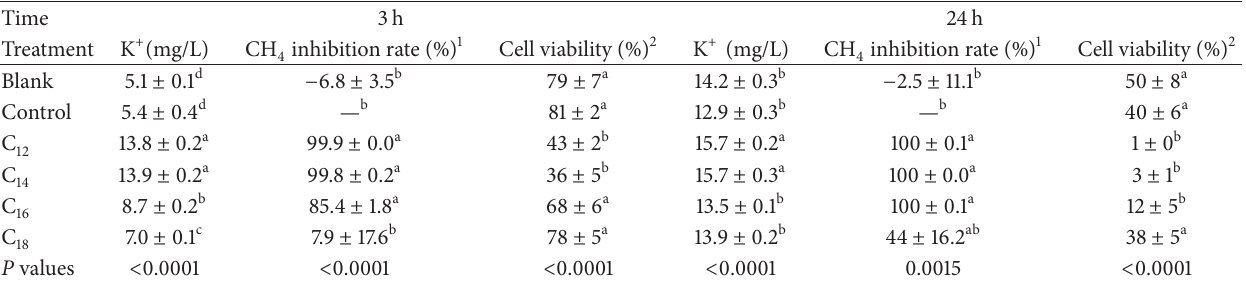
Table 2: Methane inhibition rate, K + efflux, and cell viability in cell suspensions treated with different saturated fatty acids at 10 𝜇 g/mL in Experiment 3 ( 𝑛 = 3 ; means ± standard